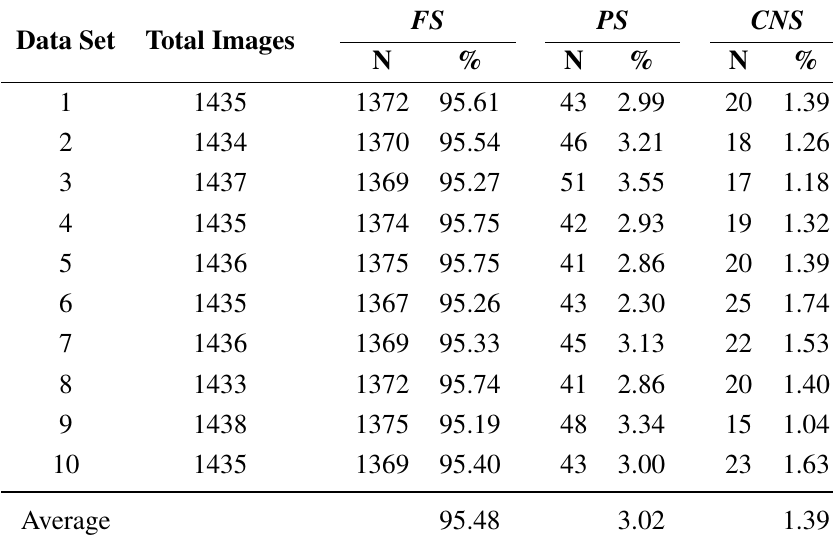
Table 2. The segmented binary images are manually classified into the three groups in the test data. FS : Full Segment; PS : Partial Segment; CNS : Cannot Segment. N: number of images; %: percentage of total